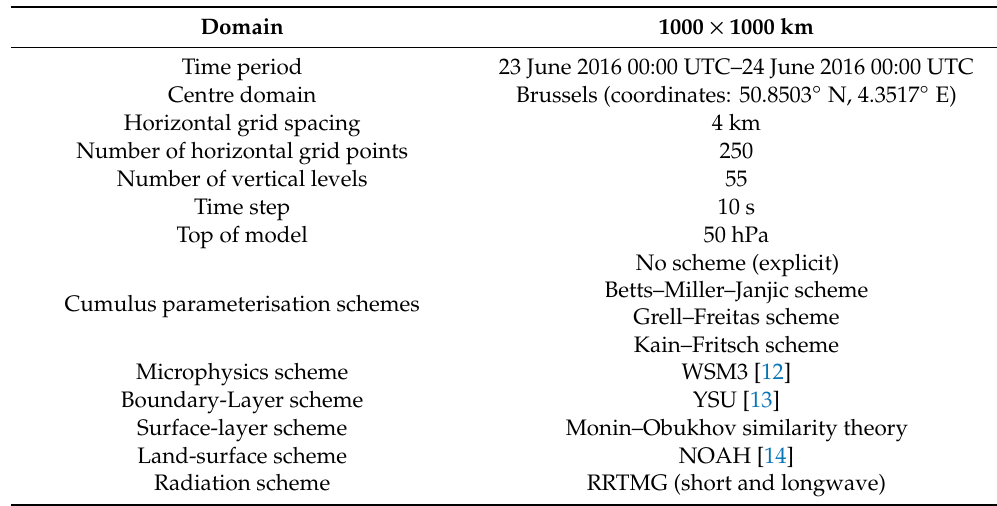
Table 1. Domain and model